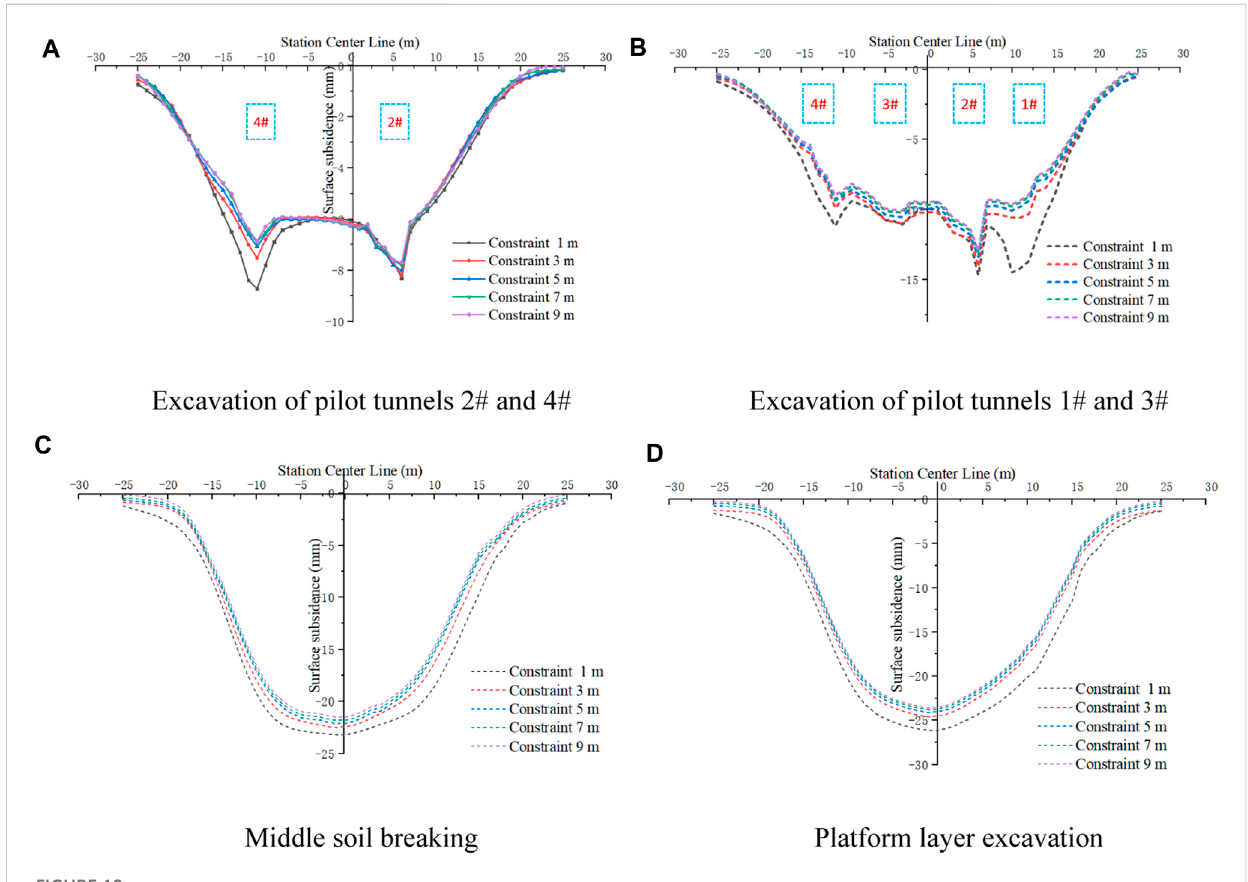
FIGURE 18 Ground surface subsidence curves with different constraint